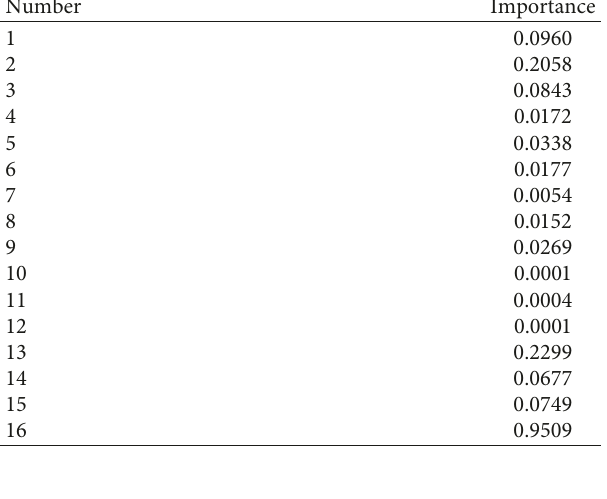
Table 14: Comparison of parameters before and after